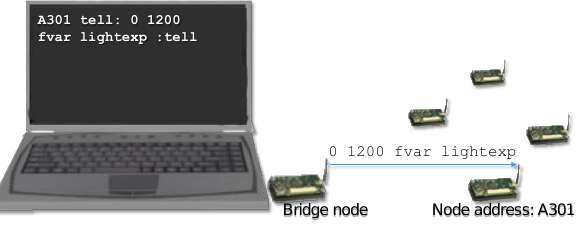
Figure 3. Similarly to Figure 1, the executable code exchange mechanism allows to define fuzzy variables and their related membership functions on already deployed nodes. To remotely define the fuzzy variable lightexp , the code to be remotely executed must be enclosed between tell: and :tell and typed at the CLI of the bridge node that sends the executable code to the destination node. The remote node receives the sequence of words 0 1200 fvar lightexp and locally interprets it.